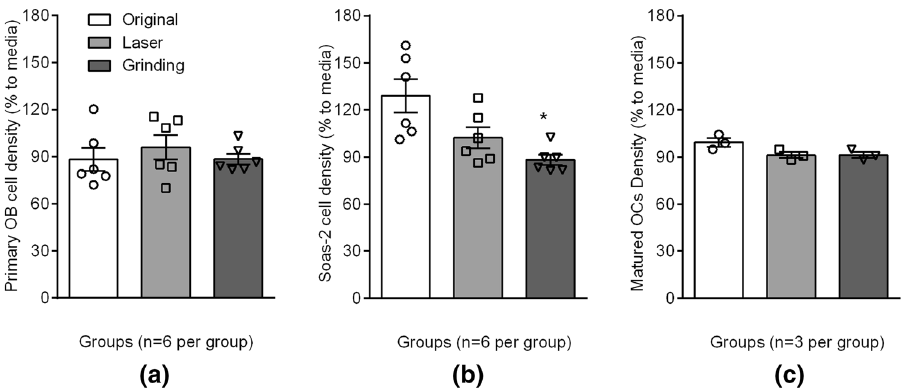
Fig. 6 In vitro biological test. a Cell proliferation of human primary osteoblasts (OBs); b Cell proliferation of Saos-2 cells; c Matured osteoclasts cells (OCs). * p <